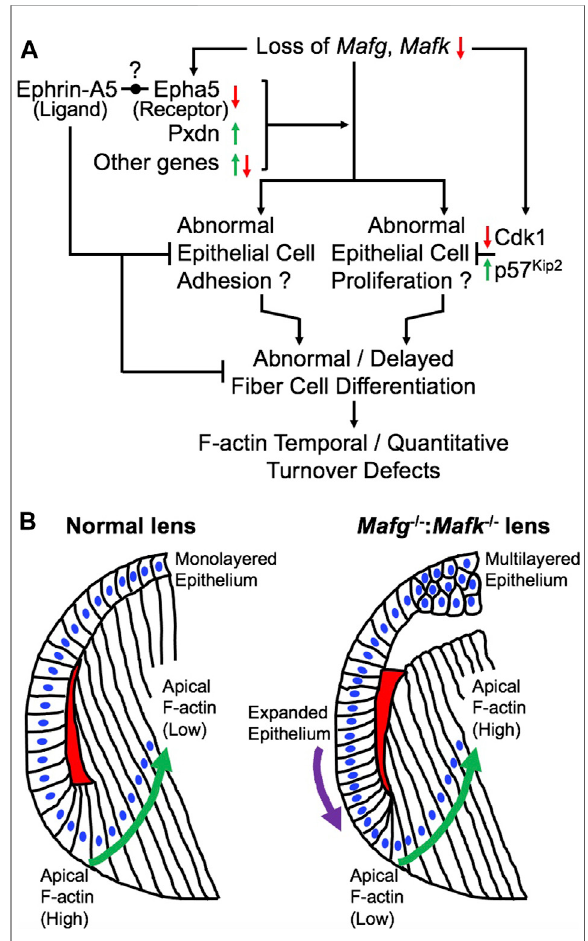
FIGURE 10 Model for the role of Mafg and Mafk in embryonic lens development. (A) Based on the fi ndings in this report, a model is proposed for the role of Mafg and Mafk in lens development. Loss